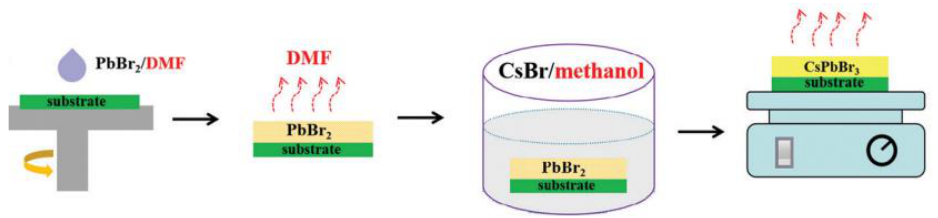
Figure 2. Schematic illustration of the preparation process of CsPbBr 3 PSCs through a two-step soaking method [32].